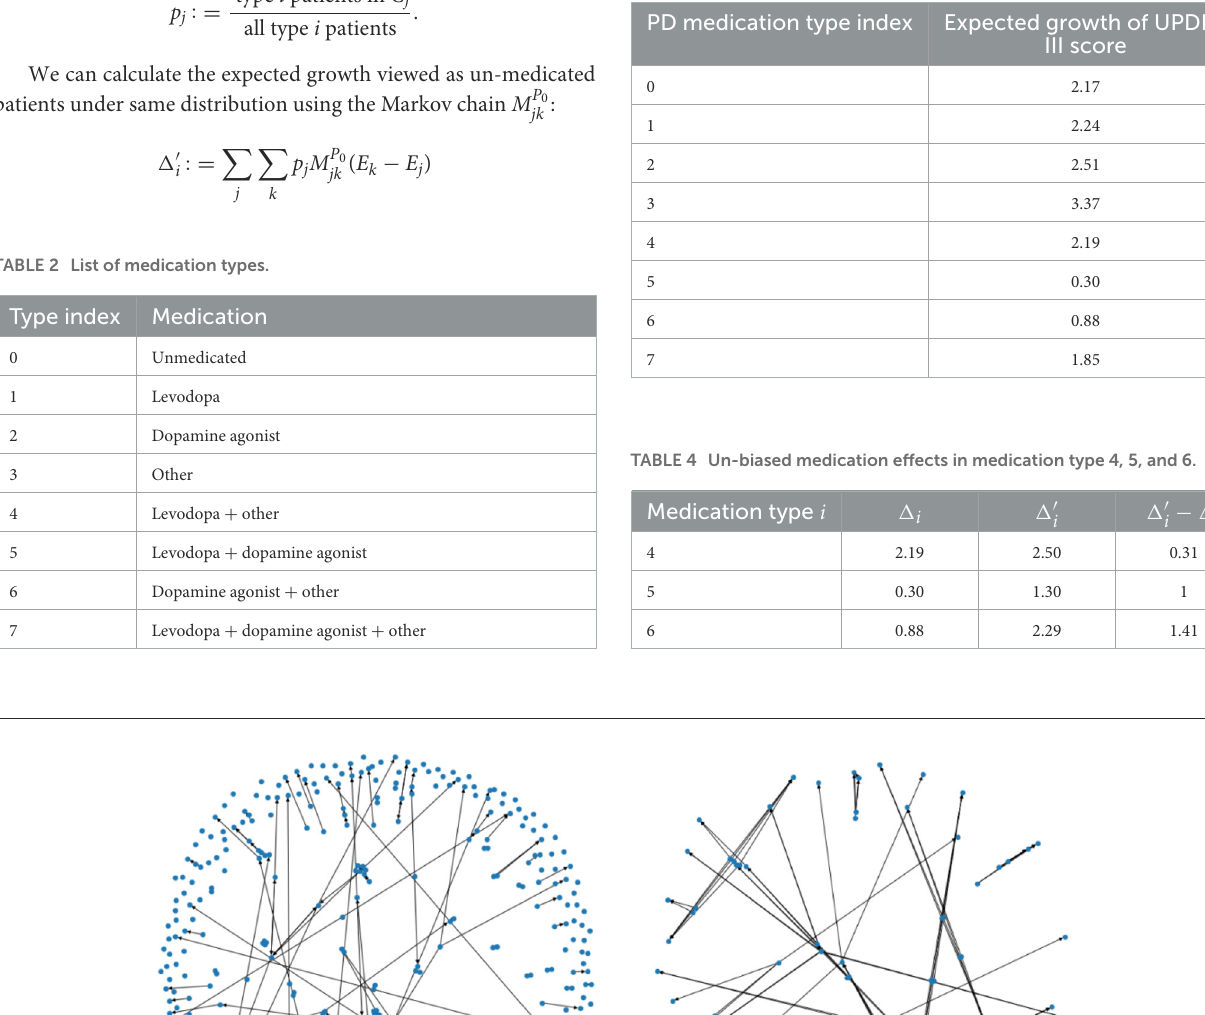
TABLE 3 Expected growth of UPDRS III score associated with different medication types.